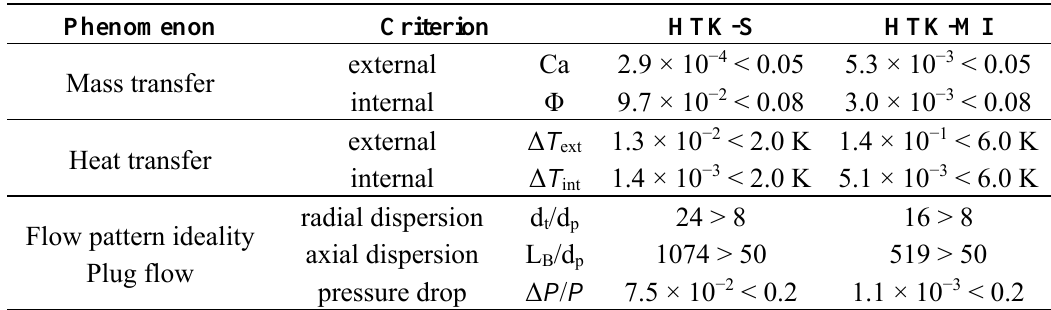
Table 2. Calculated versus limit values in the criteria for intrinsic kinetics evaluation at the most severe operating conditions used for ethanol conversion to hydrocarbons (T = 623